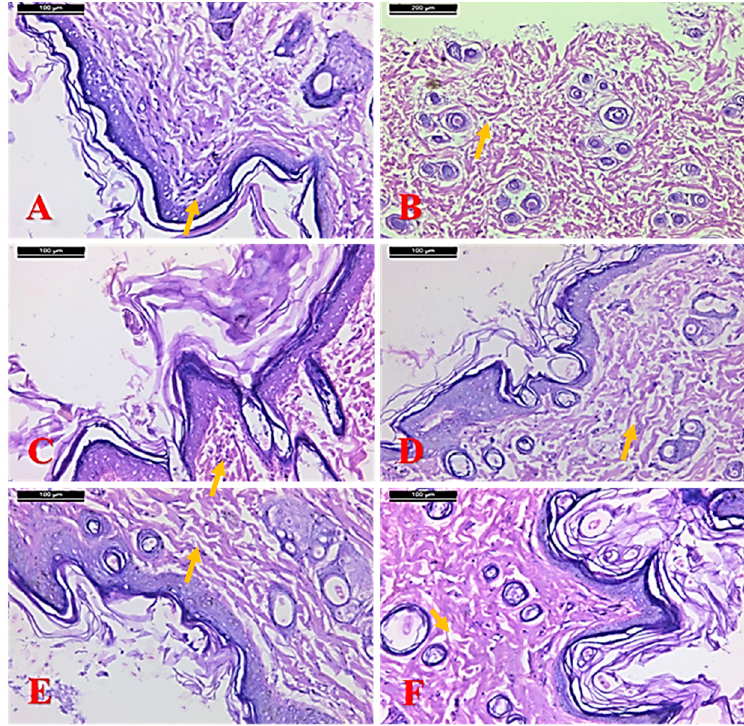
Figure 3. Photomicrographs of a skin section from ( A ) a control rat showing a well-formed thick granular cell layer, the dermis contains a deposit of collagen fibers and minimal inflammation, ( B ) control positive group, ( C ) 10% myricetin treated group, ( D ) 20% myricetin treated group, ( E ) drug-treated group, and ( F ) paraffin treated group (yellow arrows: inflammations) (H&E stain, scale bar 100 µm).